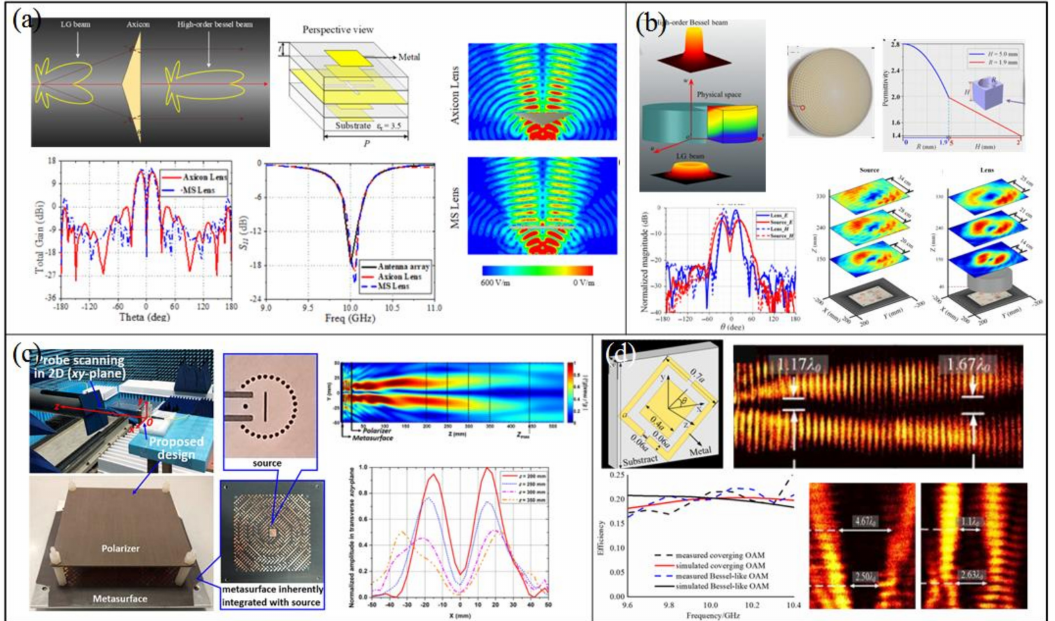
Figure 14. Non-di ff raction OAM metasurfaces and metamaterials. ( a ) A collimating metalens [47]. ( b ) A collimating all-dielectric metamaterial medium [50]. ( c ) A metasurface to generate non-di ff raction vortex beams and convert the polarization of the LP wave [81]. ( d ) A converging OAM metasurface and a non-di ff racting OAM metasurface